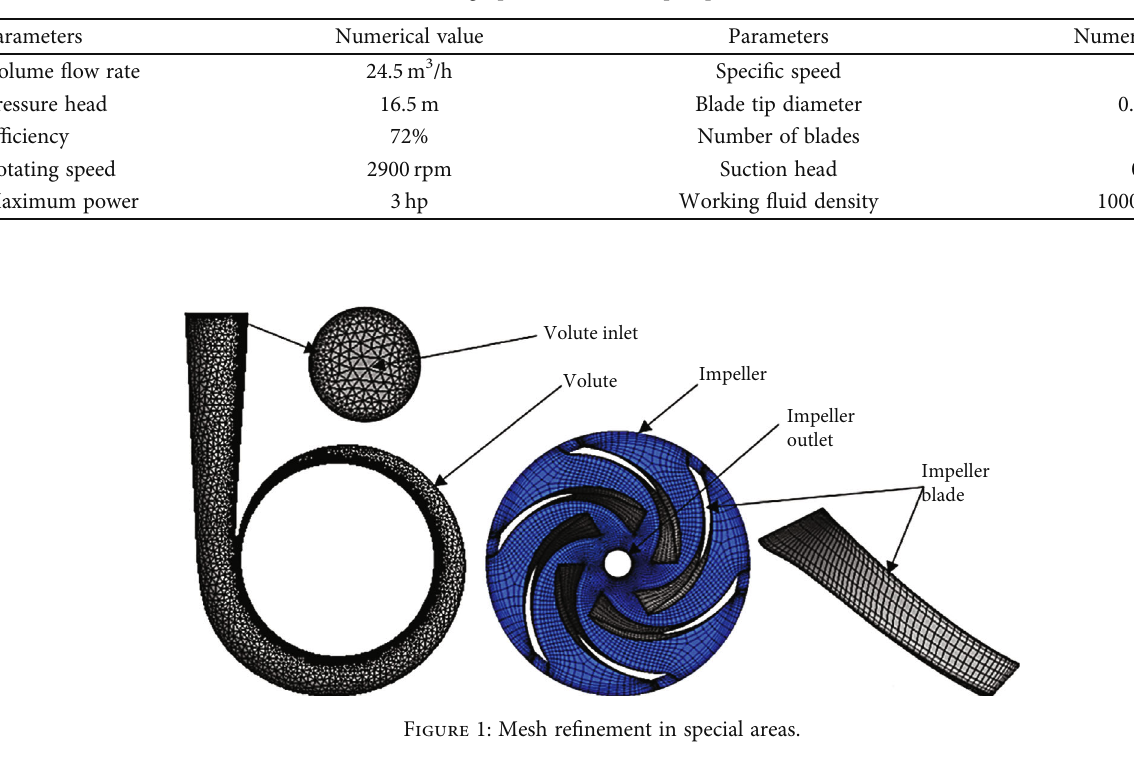
Table 1: Design parameters of the pump in direct mode.